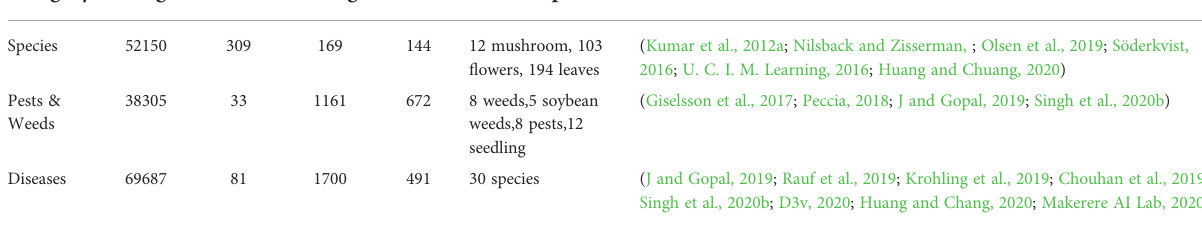
TABLE 1 Summary of AgriNet dataset per category. Category #Images #Classes Average